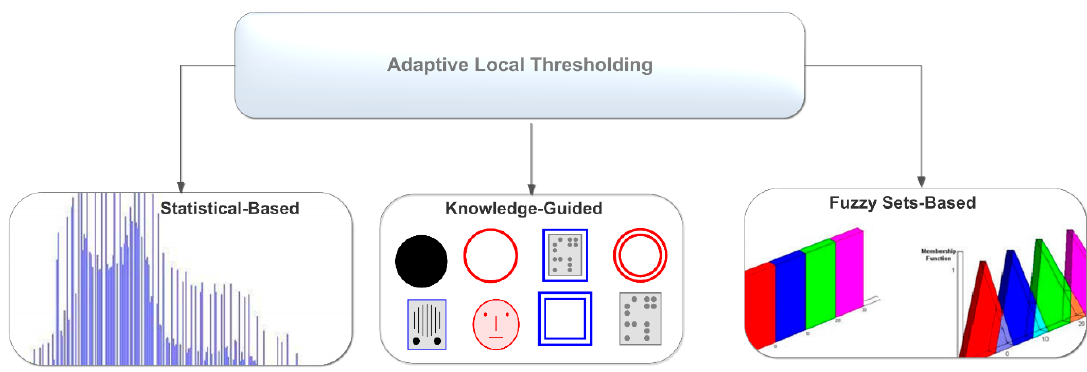
Figure 14. Adaptive local thresholding taxonomy.